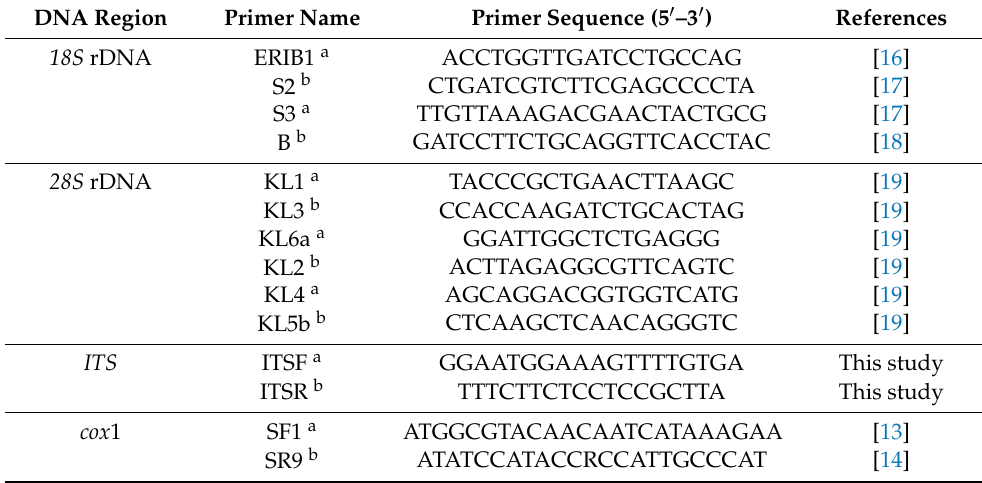
Table 1. Primers used for the amplification of four DNA regions. DNA